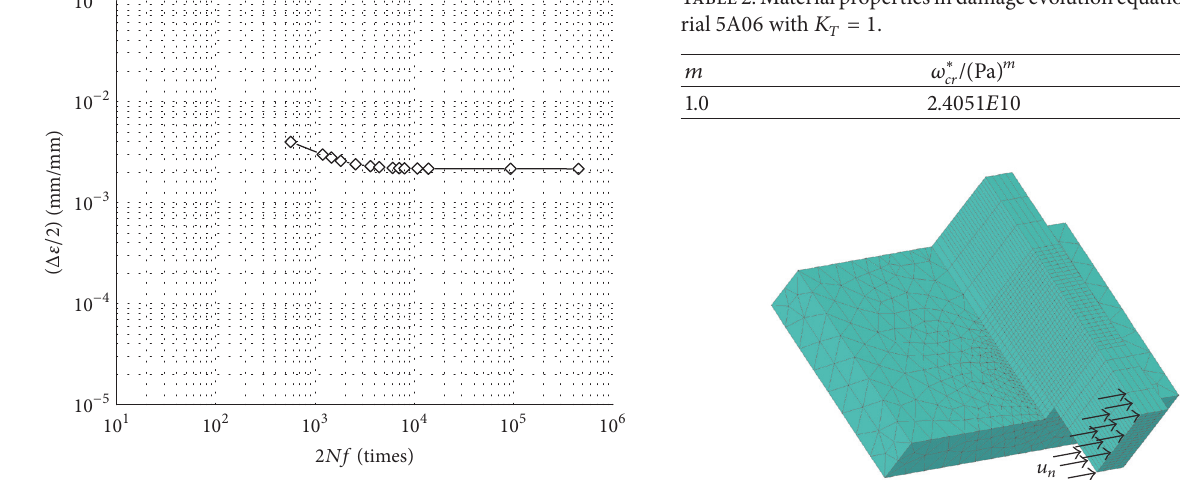
Figure 9: The mean fatigue crack initiation life curve for notched structure.